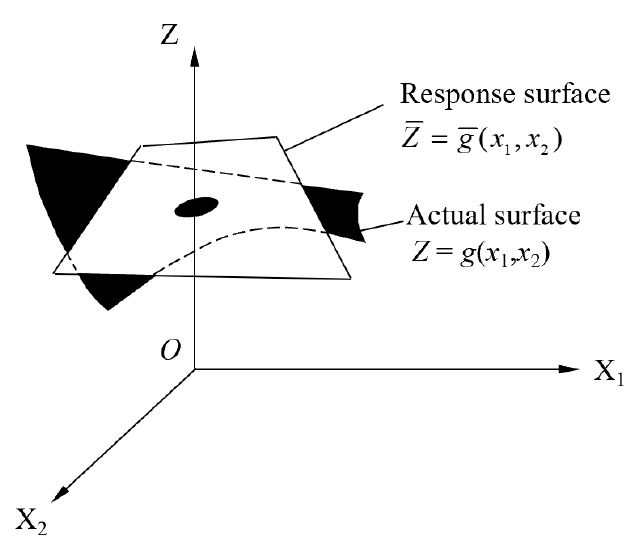
Figure 8. Schematic of the response surface.